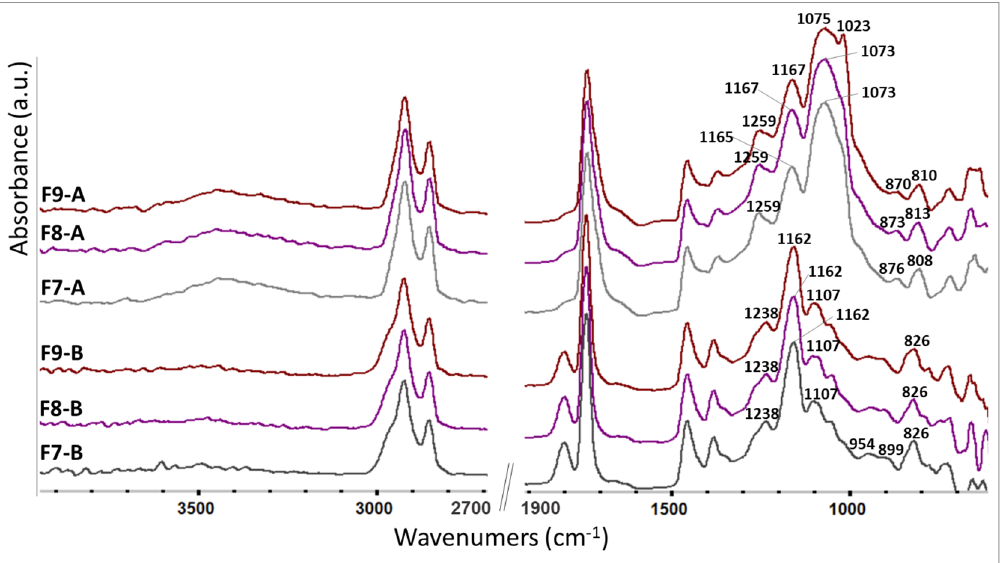
Figure 6. FTIR spectra of the initial and final F7-F9 composites. (Before curing—not. B; after curing—not. A).